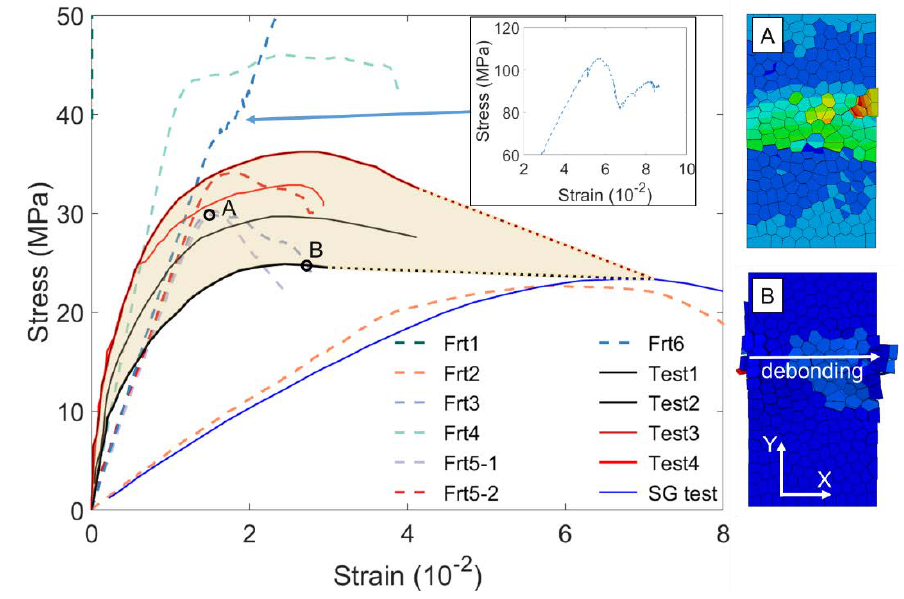
Fig. 6 Experimental and numerical results for determining fragments